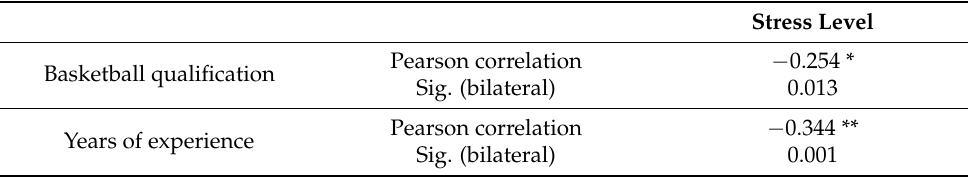
Table 3. Correlation between the stress level and years of experience and basketball qualification. Basketball qualification